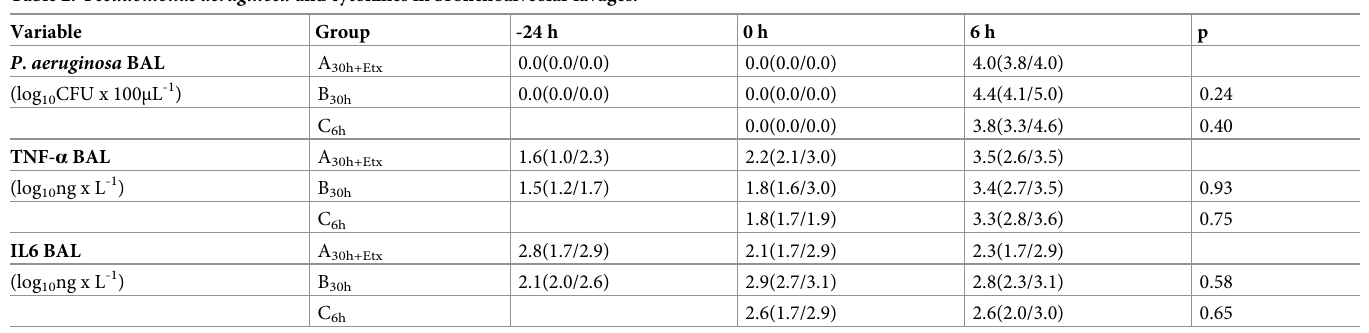
Table 2. Pseudomonas aeruginosa and cytokines in bronchoalveolar lavages.